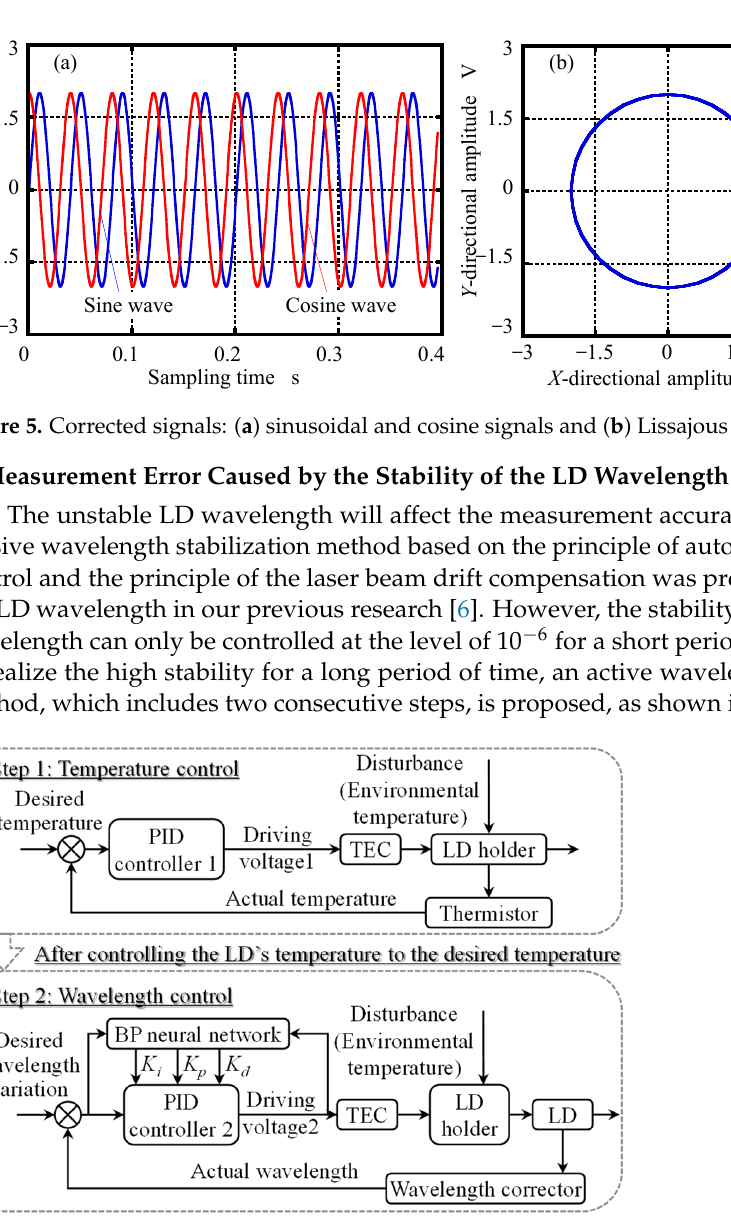
Figure 6. Flowchart of the active control of the laser wavelength stability.